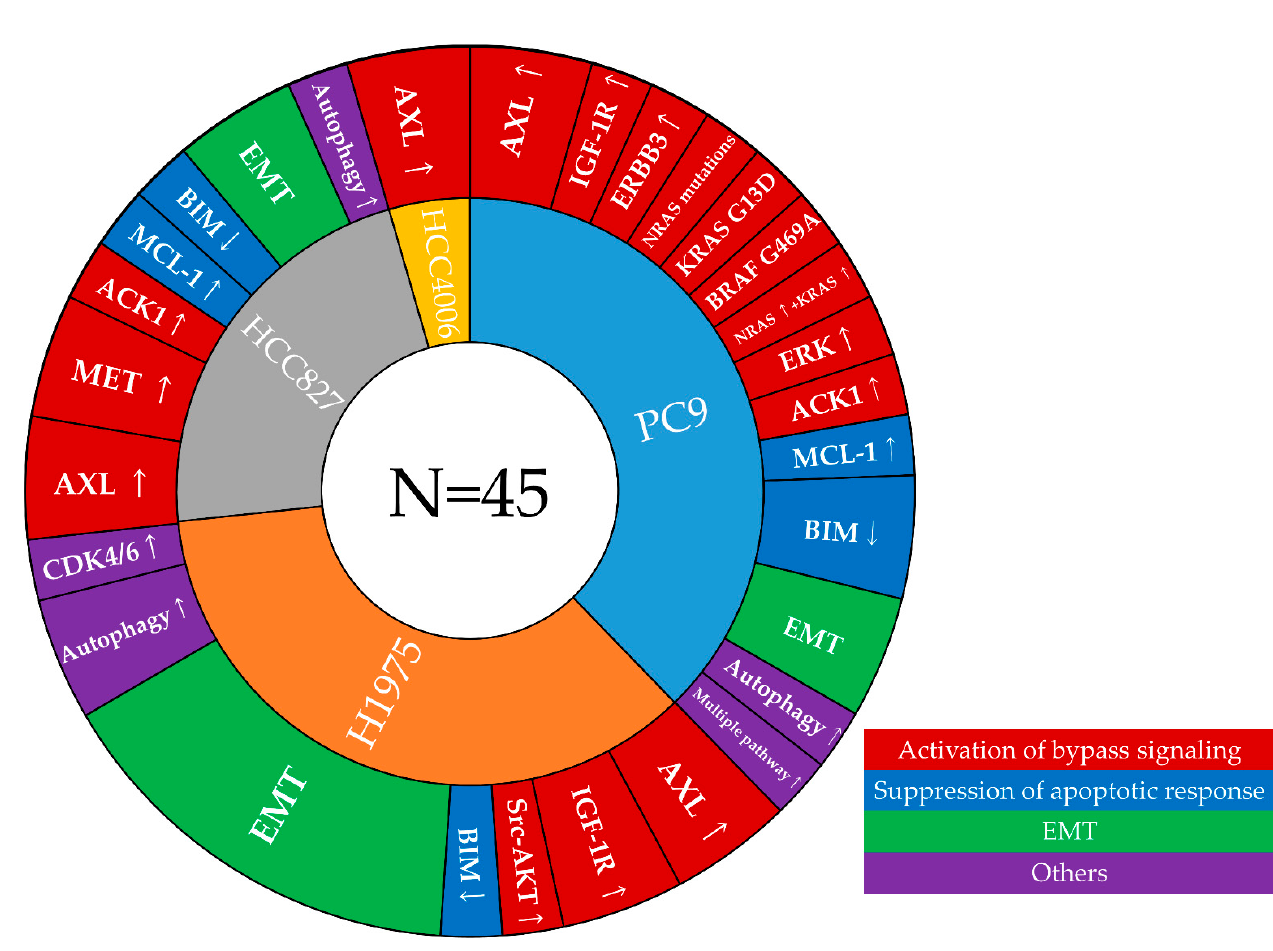
3 of 14 3. Cell Line Models Used to Analyze Resistance Mechanisms to First-Line Osimer-